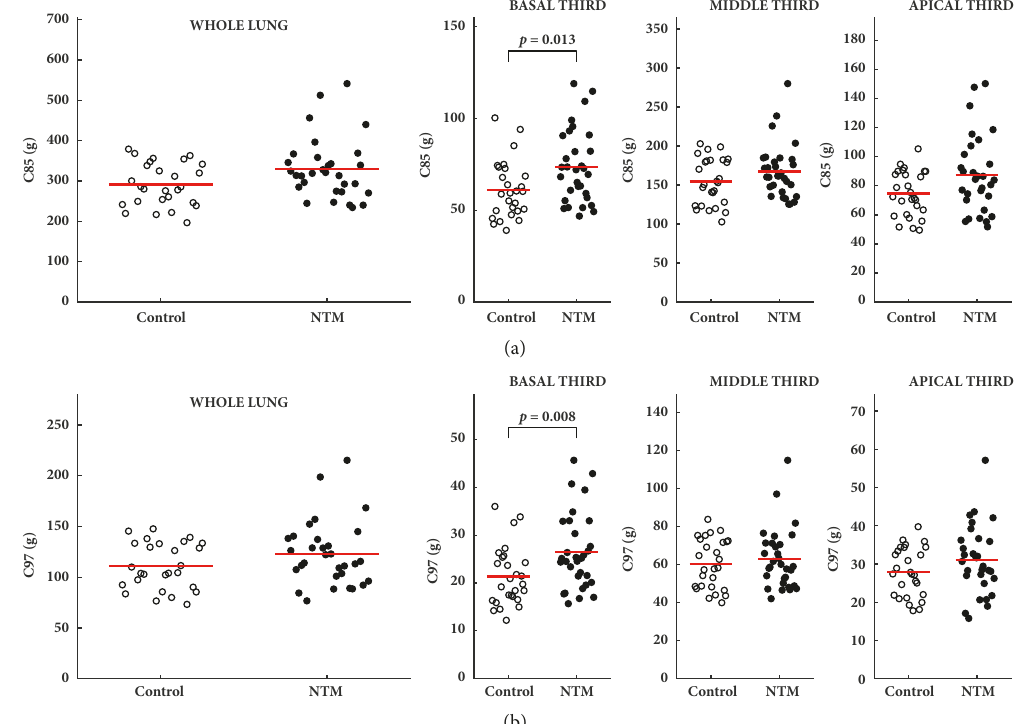
Figure 2: Comparisons between the control group and the nontuberculous mycobacteria group (NTM) for complement measurements, which represents the total lung mass (100%) minus the 15% (C85) (a) or 3% (C97) (b) mass of the total lung